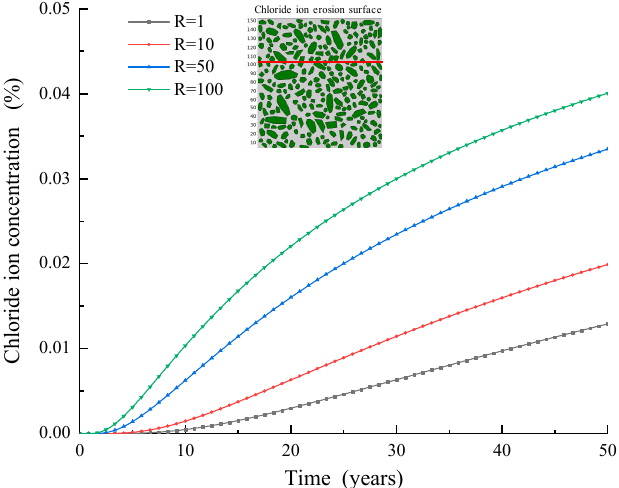
Figure 13. Chloride ion concentration–time curve (R = 1\10\50\100).